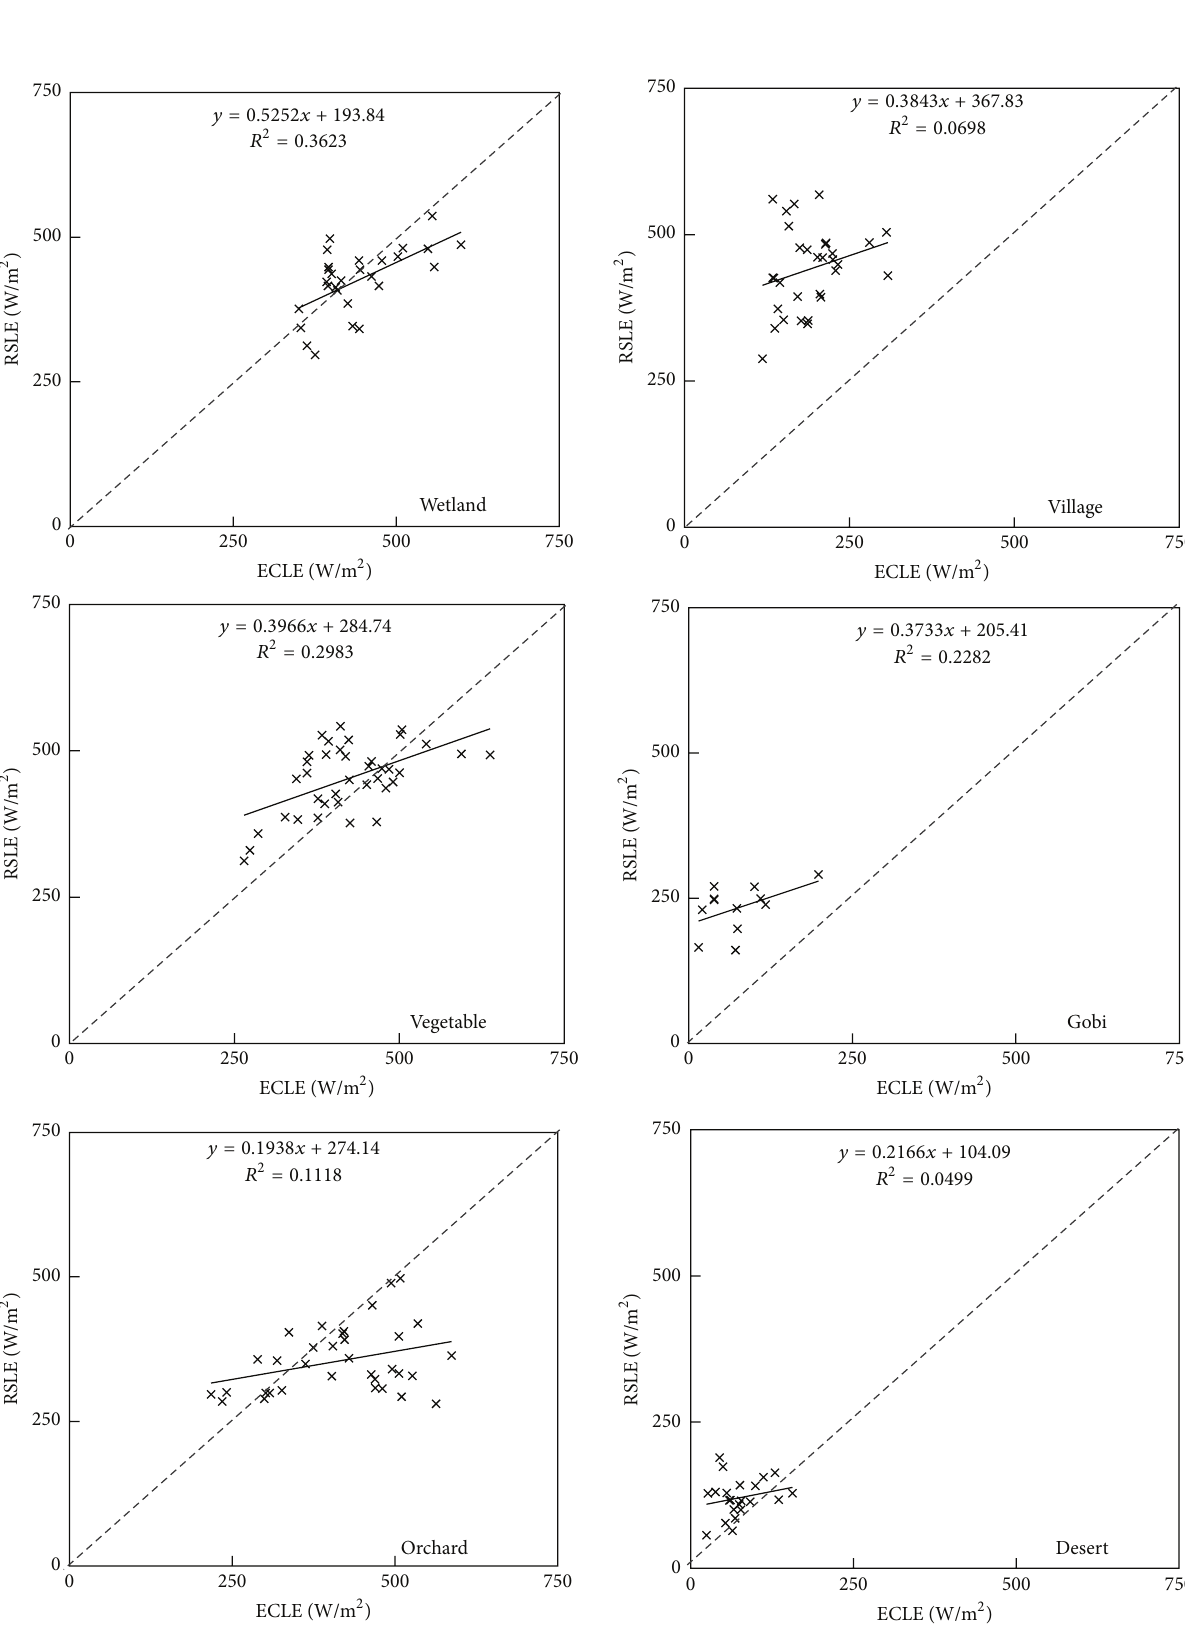
Figure 6: Comparisons between ECLE and RSLE at 6